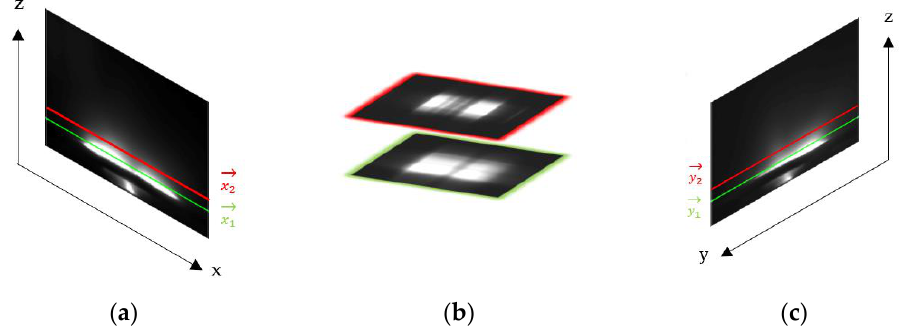
Figure 10. Schematic of the reconstruction of the 3D model: ( a ) left observation with two lines; ( b ) the two calculated cross-sectional images from the lines in ( a , c ); ( c ) right observation with two lines.